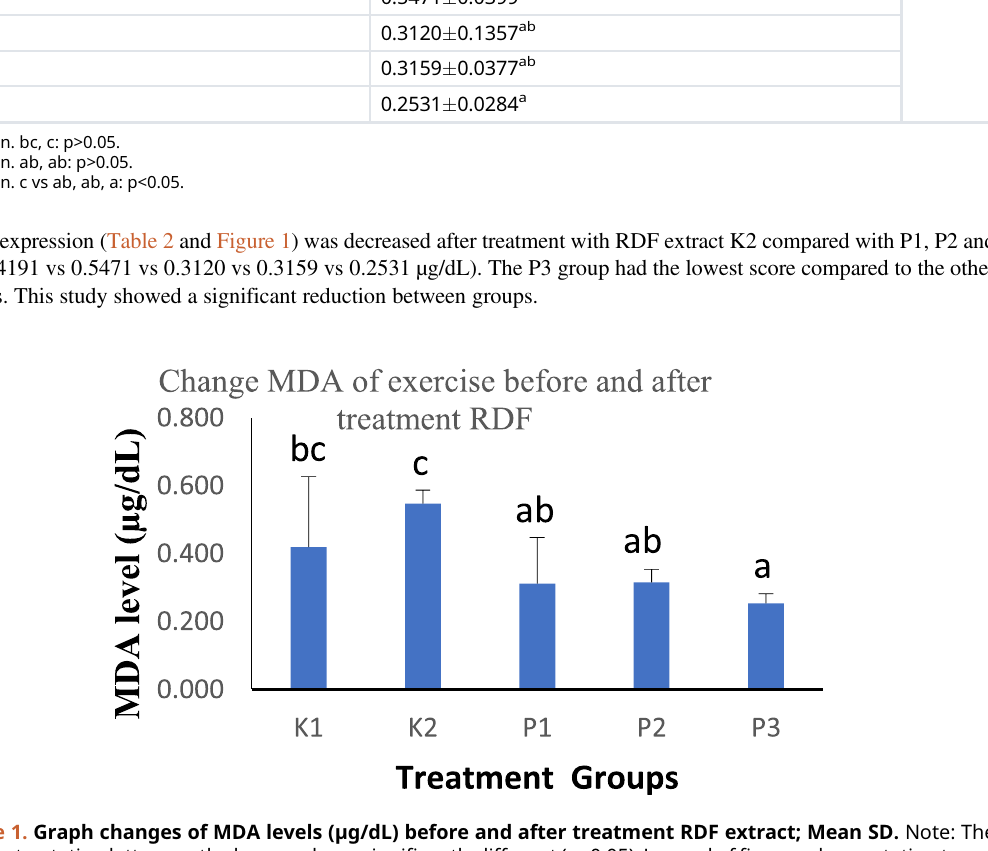
Figure 1. Graph changes of MDA levels ( μ g/dL) before and after treatment RDF extract; Mean SD. Note: The different notationletterson thebargrapharesignificantlydifferent (p<0.05).Legend offigure:abc=notationtosee the difference is real or not, if a means the difference is not real. If a b = significant difference